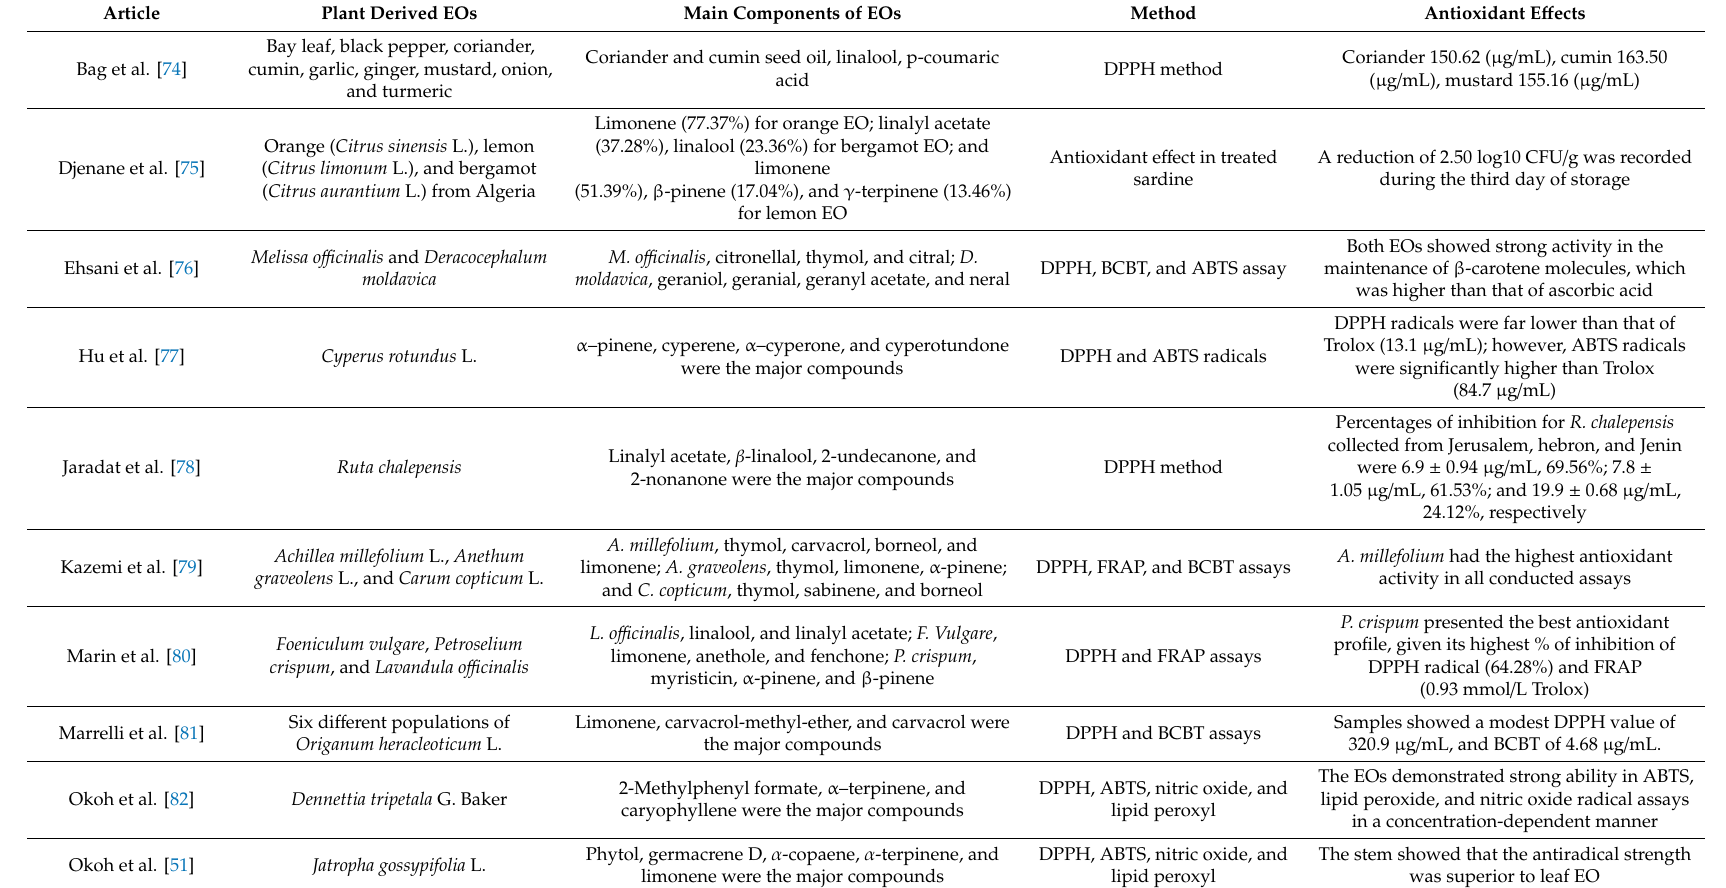
Table 3. Main characteristics of studies related with antioxidant properties of essential